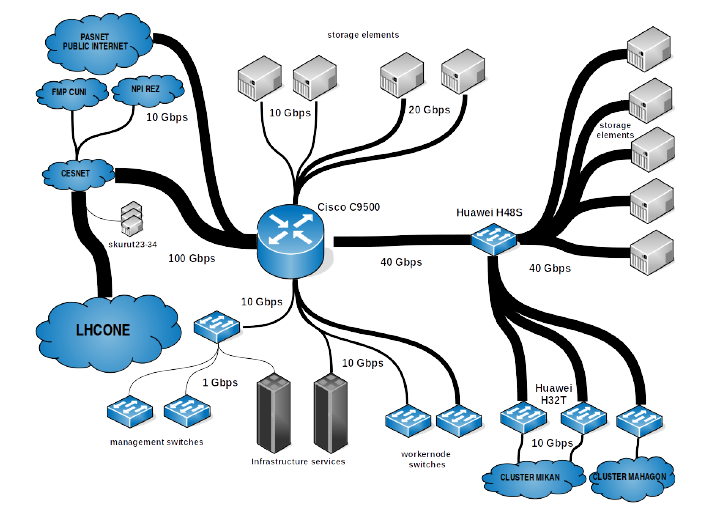
Figure 3. Schematic of praguelcg2 networking